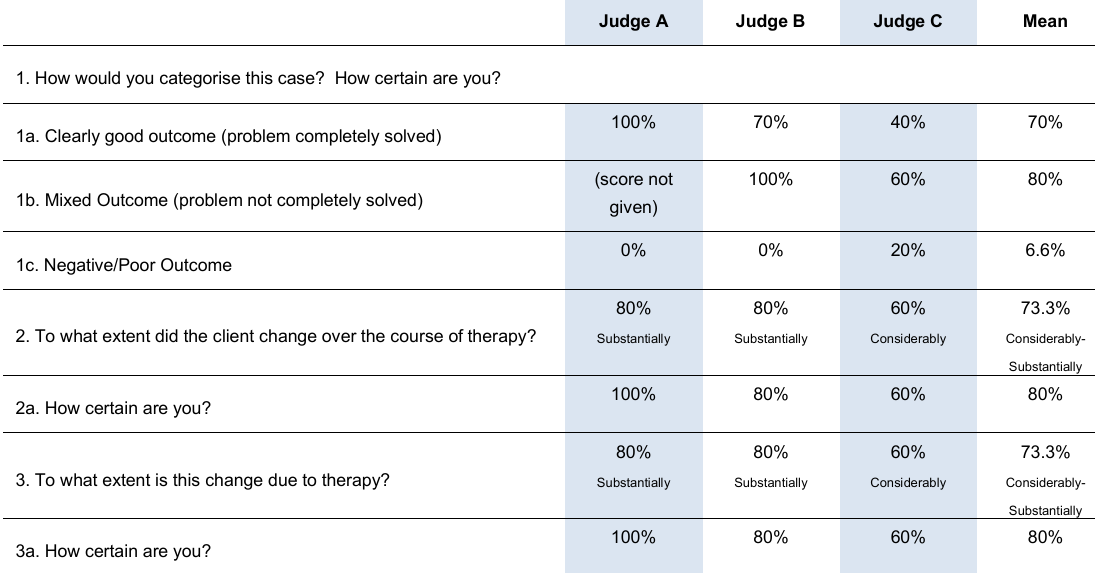
Table 3: Adjudication